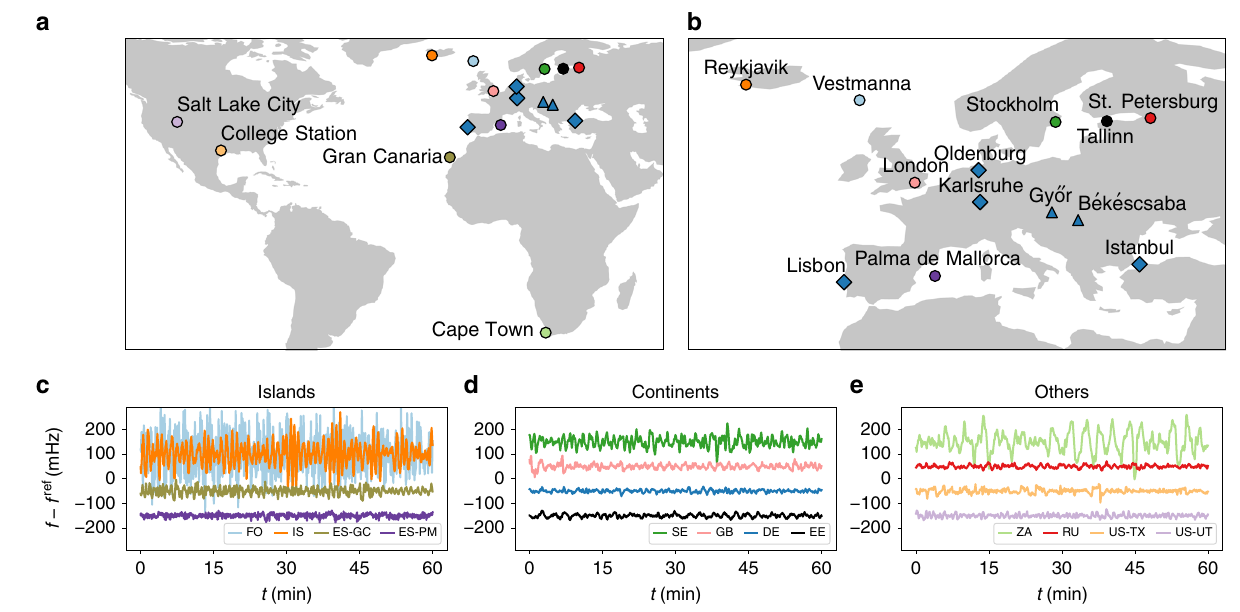
Fig. 1 Overview of available frequency data. a Different locations in Europe, Africa, and Northern America at which frequency measurements were taken. Australia and large parts of Asia are not displayed, as there were no measurements recorded. b Zoom of the European region (excluding Gran Canaria) with all locations labelled. Circles indicate measurement sites where single measurements for several days were taken, diamonds mark the four locations where we performed GPS-synchronised measurements, and triangles mark sites for which we received additional data. c – e Frequency trajectories display very different characteristics. We plot 1 h extracts of the deviations from the reference frequency of f ref = 50 Hz (or 60 Hz for the US power grids), which are offset from the zero mean to improve readability. Panels c – e and following plots abbreviate the measurement sites using the ISO 3166 code for each country and each location is assigned a colour code, as in the maps in a and b . For more details on the data acquisition and measurement locations, see Supplementary Note 1 and ref. 32 . Maps were created using Python 3 and